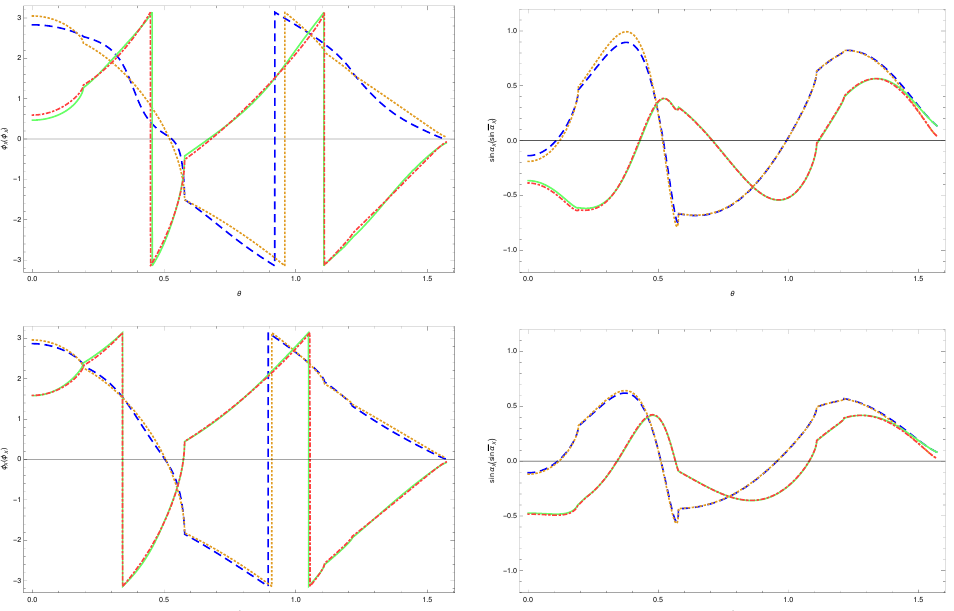
Figure 4 . The left panels show comparison of (cid:30) X obtained from numerical diagonalization (blue dashed lines) vs. the approximate formulae of eq. (3.17) (orange dotted lines) and similarly for (cid:22) (cid:30) X and eq. (3.20) (green solid and red dot-dashed line, respectively) as a function of the azimuthal angle. The right panels show the analogous comparison of sin (cid:11) X and sin (cid:22) (cid:11) X . Chosen neutrino energies are E = 300 MeV for the upper row and E = 500 MeV for the lower row. Normal mass ordering is